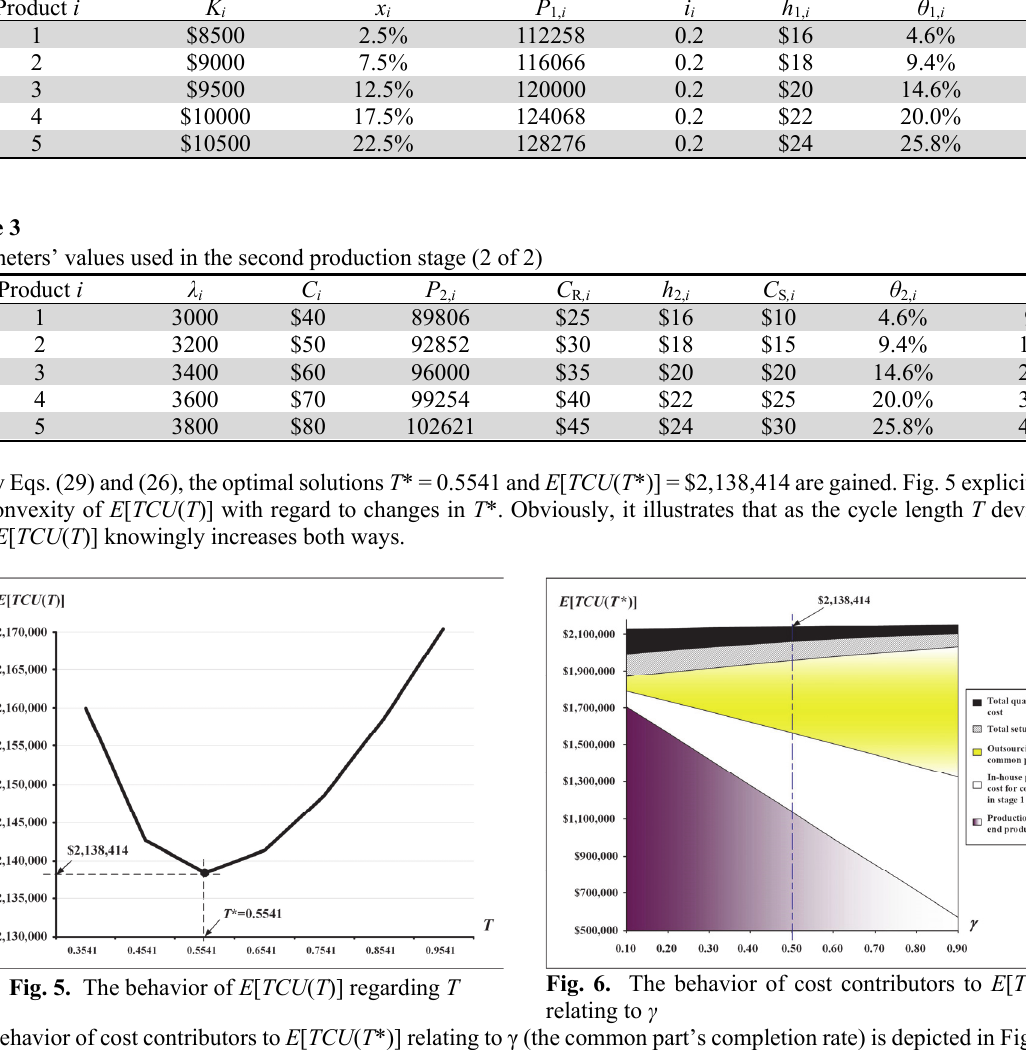
Parameters’ values used in the second production stage (1 of 2) Product i